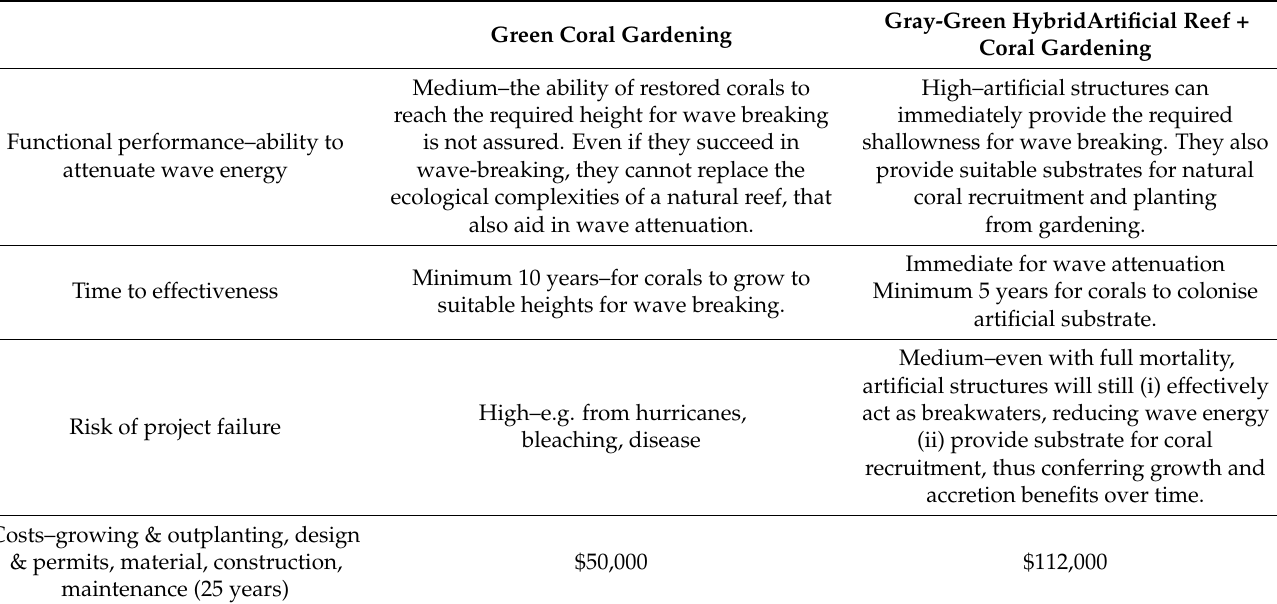
Table 1. Summary of performance, timeframes, risk and costs ($USD) for coral gardening and hybrid solutions, over 360 sq m. from a case study carried out in